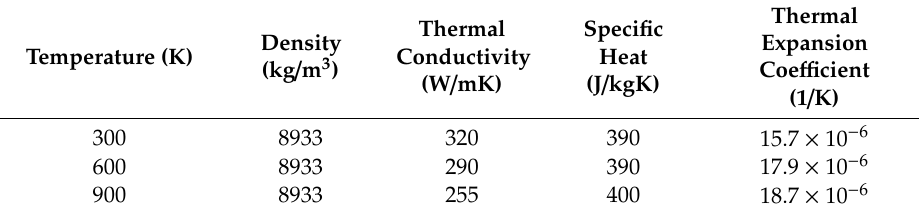
Table 4. Physical and Thermal properties of the copper alloy (CuCrZr).